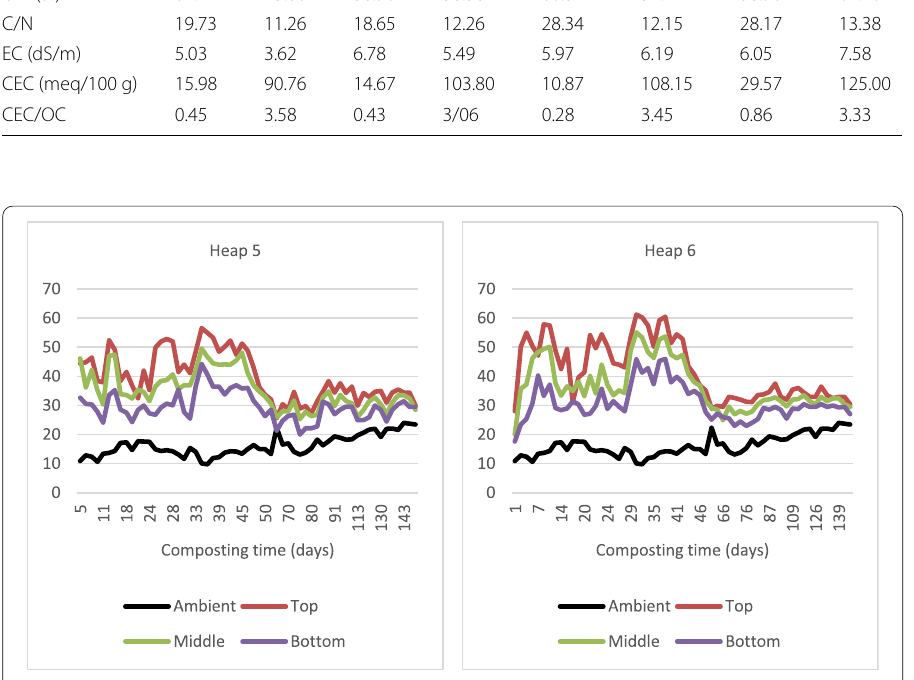
Fig. 1 Ambient and heap temperature evolution during co‑composting of TM and OP for H5 and H6. Ambient (black); Top (brown); Middle (green); Bottom